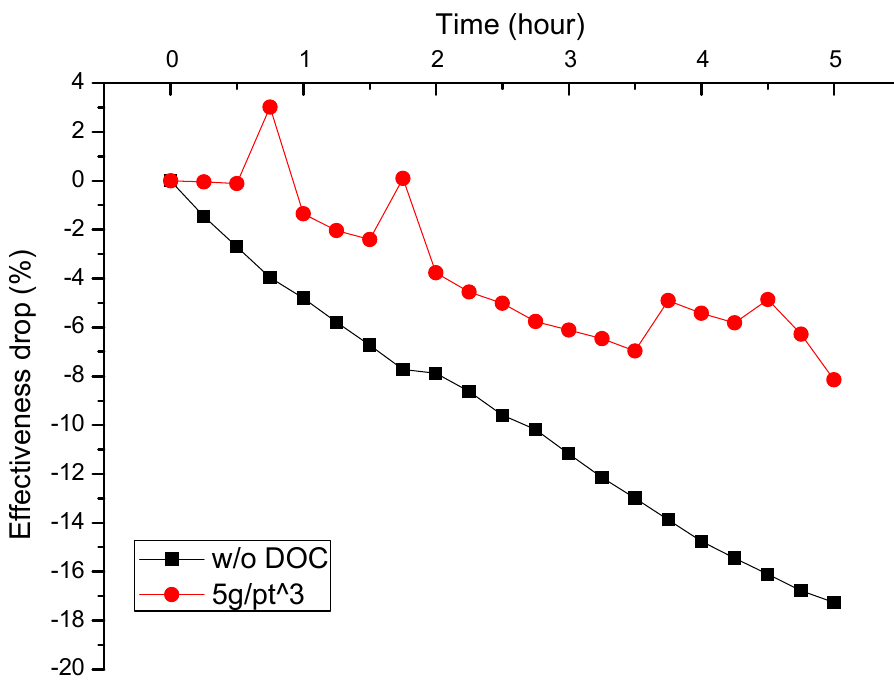
Figure 7. Decline in effectiveness over the course of 5 h with respect to DOC catalyst. Engine speed: 2000 rpm, BMEP: 6 bar, flow rate: 1.8 g s − 1 , coolant temperature: 60 ◦ C, and EGR inlet gas temperature: 420 ◦